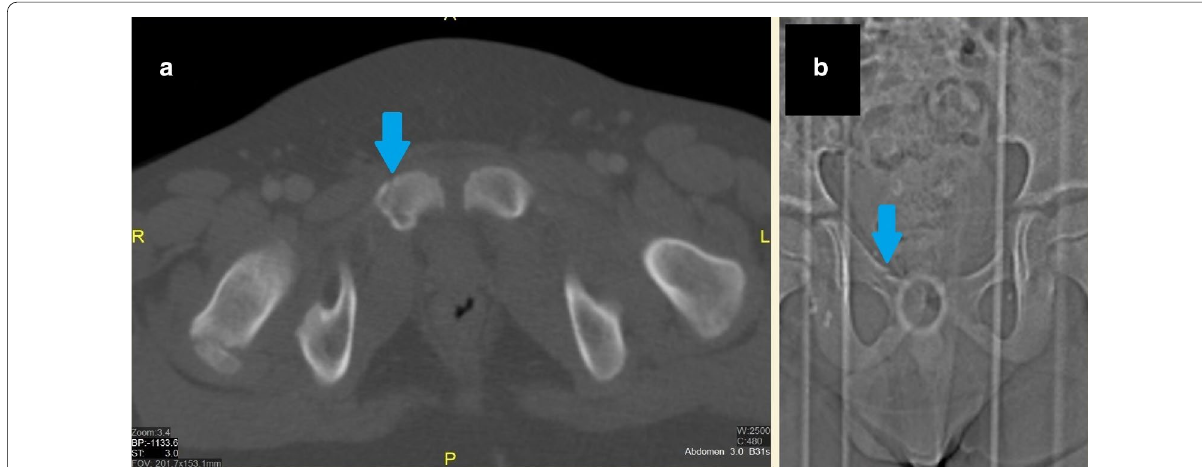
Fig. 20 Scout neglect bias. An abdominal CECT of a male patient was performed to evaluate solid organ injury after a motor vehicle accident. A right pubic fracture (blue arrows) was masked in routine abdominal CT images of 3 mm slice thickness with a soft filter ( a ). However, it was easily seen in the scout image without any doubt ( b )